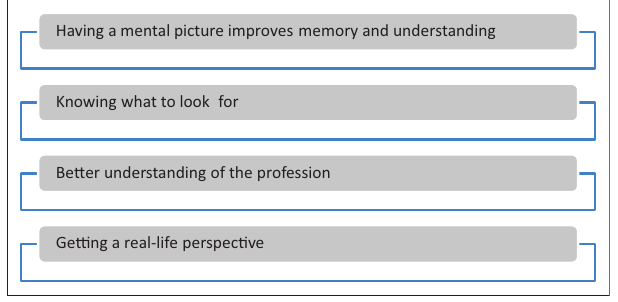
FIGURE 2: Themes identified from focus group discussions on the inclusion of video cases in a theory module in an undergraduate speech therapy